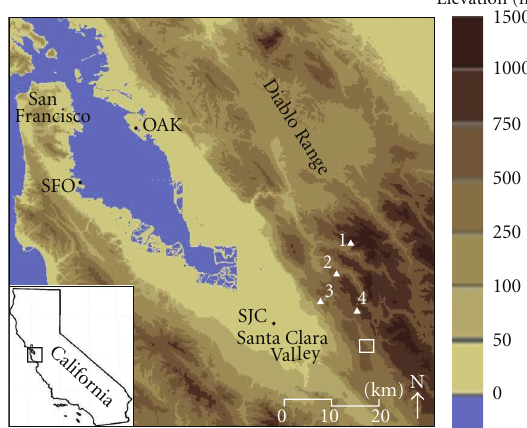
Figure 1: A map of San Francisco Bay Area to define the geo- graphical locations of Joseph D. Grant County Park (box) and four nearby RAWS stations ((1) Rose Peak (RSPC1), (2) Poverty (MIPC), (3) Alum Rock (RJSC1), and (4) CDF portable 10 (TR098)). Major airports are also indicated for reference, San Francisco (SFO), Oakland (OAK), and San Jos´e (SJC) Elevation above mean sea level (MSL) is shaded according to the